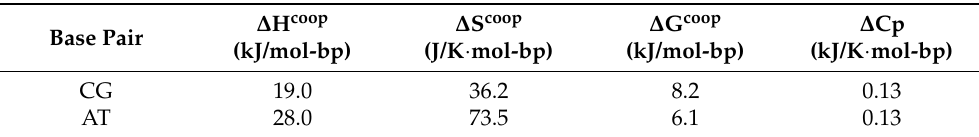
Table 1. Contributions of CG and AT base pairs to the enthalpy, entropy, Gibbs free energy, and heat capacity increment in DNA dissociation (melting). See Ref. [16].